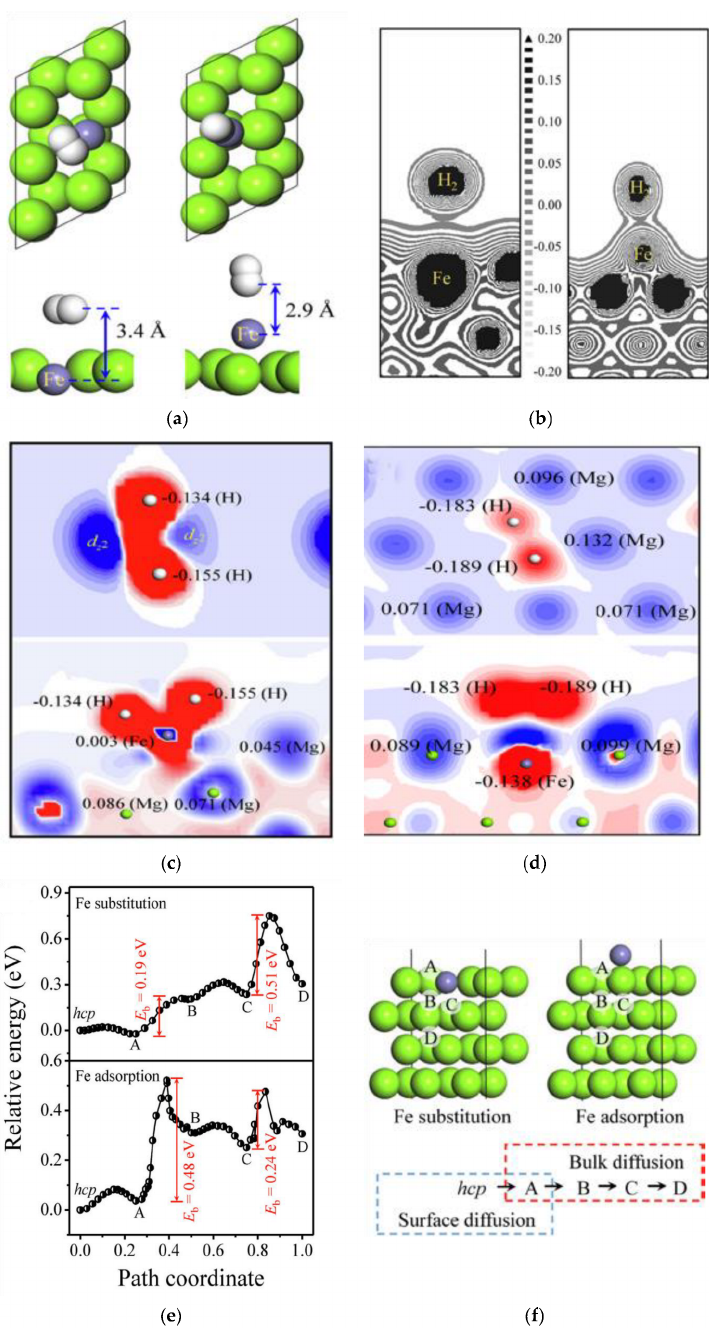
Figure 24. ( a ) Schematic images of H 2 molecule adsorption on the atomic-Fe-substituted (left) and the atomic-Fe-adsorbed (right) Mg(0001). The green, brown, and white balls represent Mg, Fe, and H atoms, respectively. ( b ) Charge density distributions for the atomic-Fe-substituted (left) and the atomic-Fe-adsorbed (right) Mg(0001) after H 2 adsorption. ( c ) Deformation charge density distributions and Mulliken charges for the TS of H 2 dissociation on the atomic-Fe-adsorbed Mg (0001). ( d ) Deformation charge density distributions and Mulliken charges for the TS of H 2 dissociation on the Fe-substituted Mg(0001). ( e ) Minimum energy paths (MEPs) for the H atom diffusion on the atomic-Fe-substituted and atomic-Fe-adsorbed Mg(0001). ( f ) Diffusion routes of the H atom on the atomic-Fe-substituted and atomic-Fe-adsorbed Mg(0001). ( a – f ) Reproduced with permission [187]. Copyright 2019,